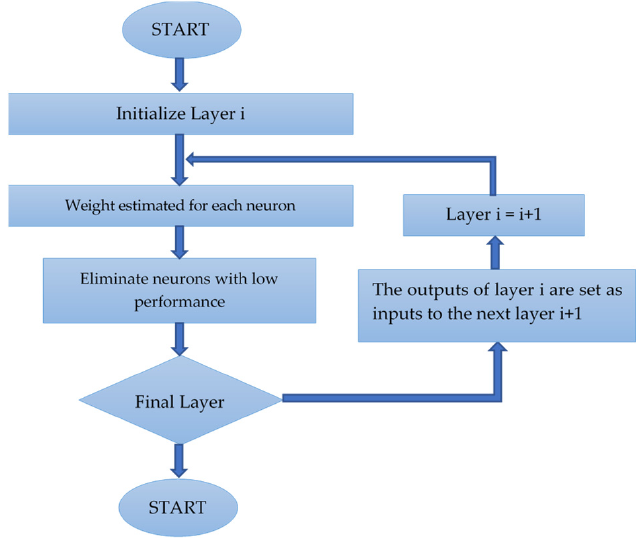
Figure 6. The layer-building algorithm used in the training of a GMDH—ANN.